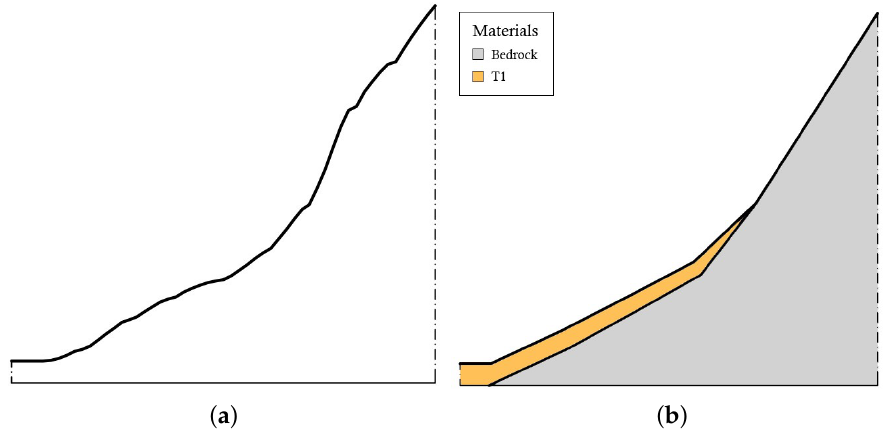
Figure 6. The calculation profile considered in the stability analysis for